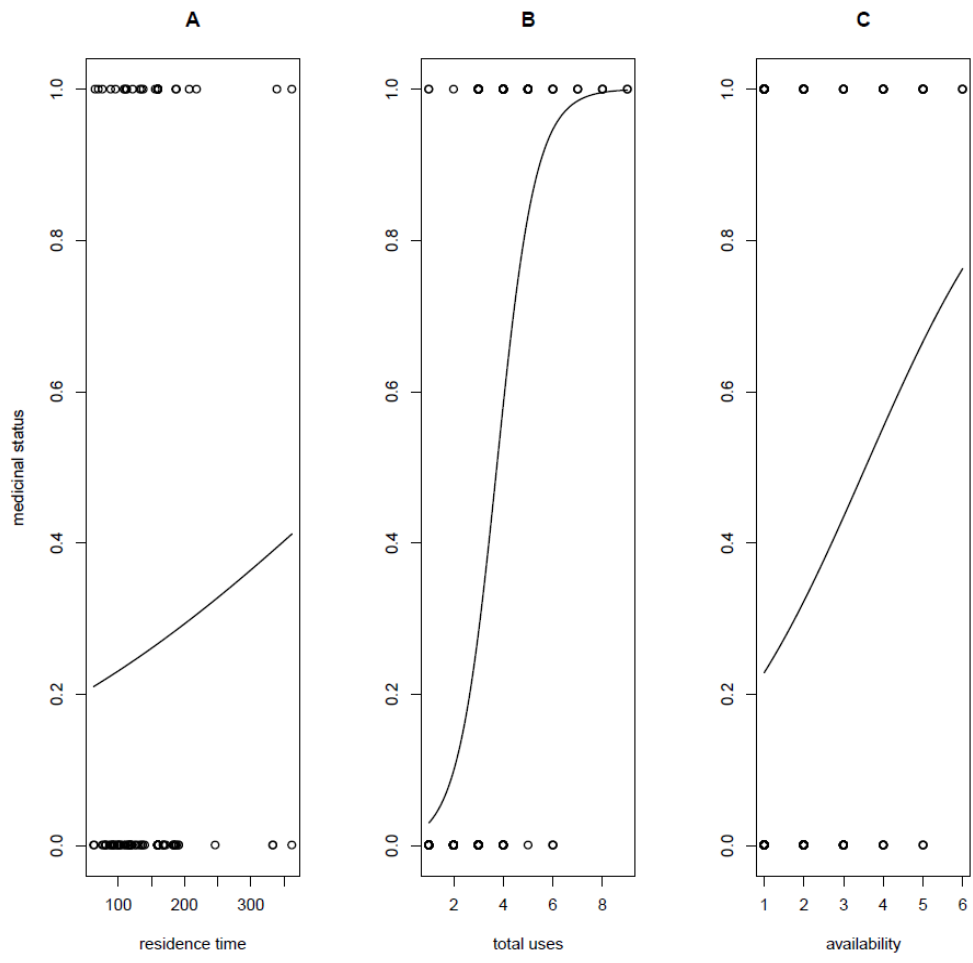
Figure 3. Significant relationships in the theoretical framework defining the time-since-introduction theory. Relationships between medicinal status and residence time ( A ), total use ( B ), and availability ( C ).